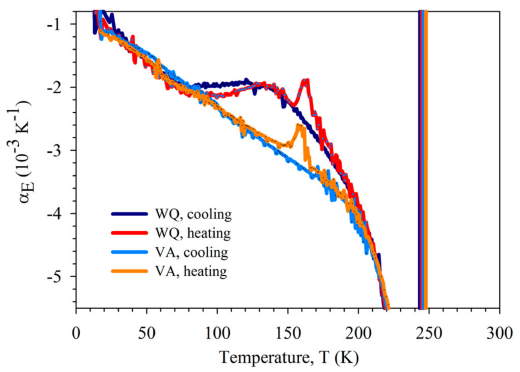
Figure 3. Temperature dependence of the temperature coefficient of the effective Young’s modulus of the Ti 50 Ni 46.1 Fe 3.9 sample after water quenching (WQ) or vacuum annealing (VA), derived from the curves shown in Figure